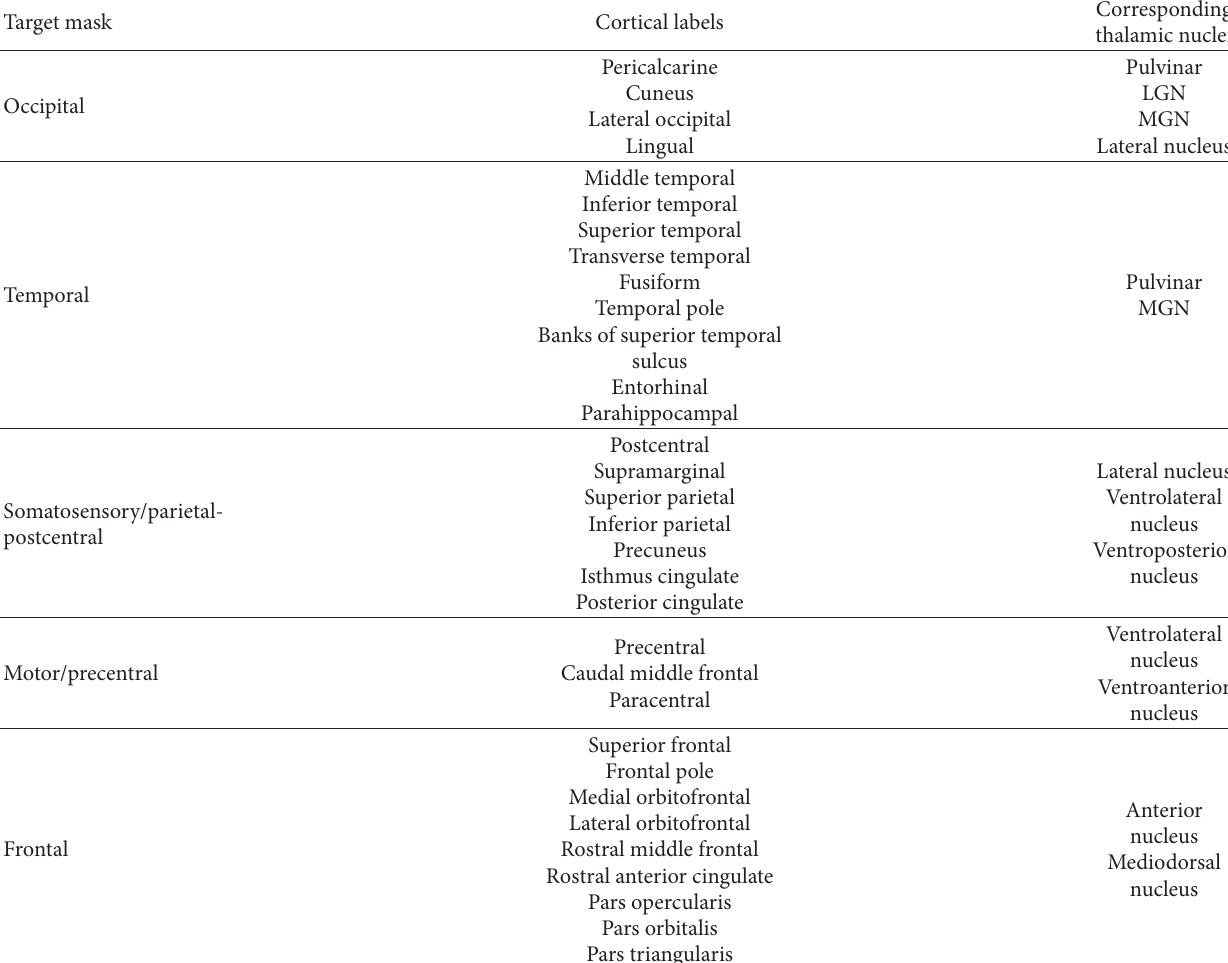
Table 1: Overview of the cortical target masks and the corresponding thalamic